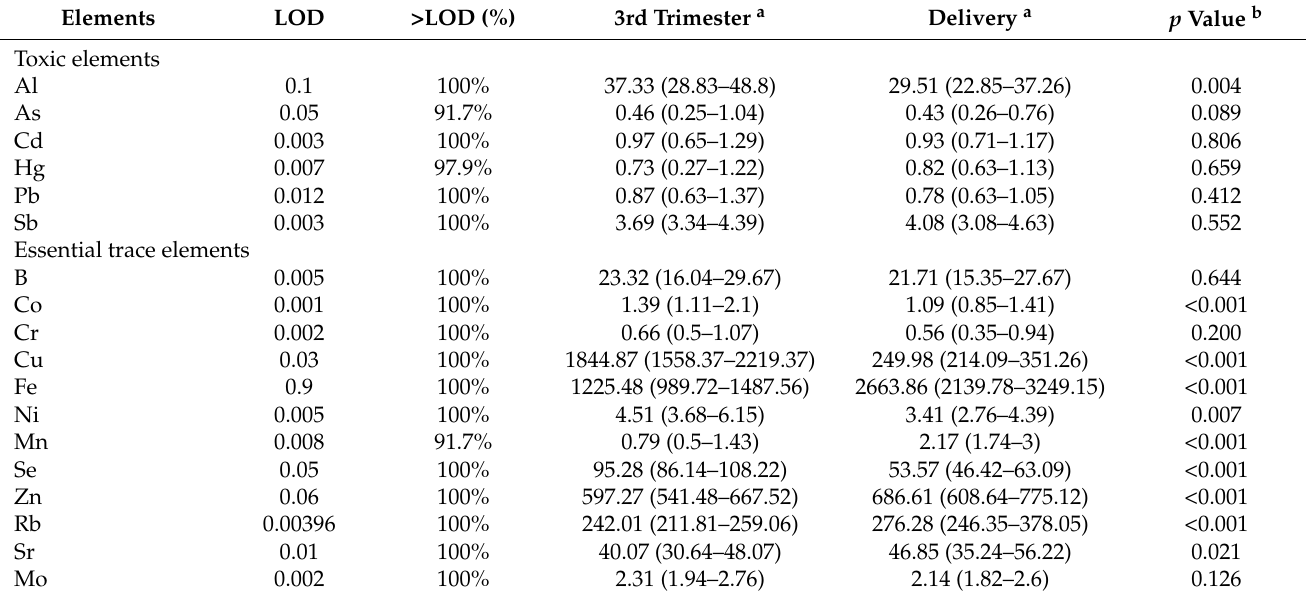
Table 3. Differences in element concentrations in maternal plasma at 3rd trimester and cord plasma.